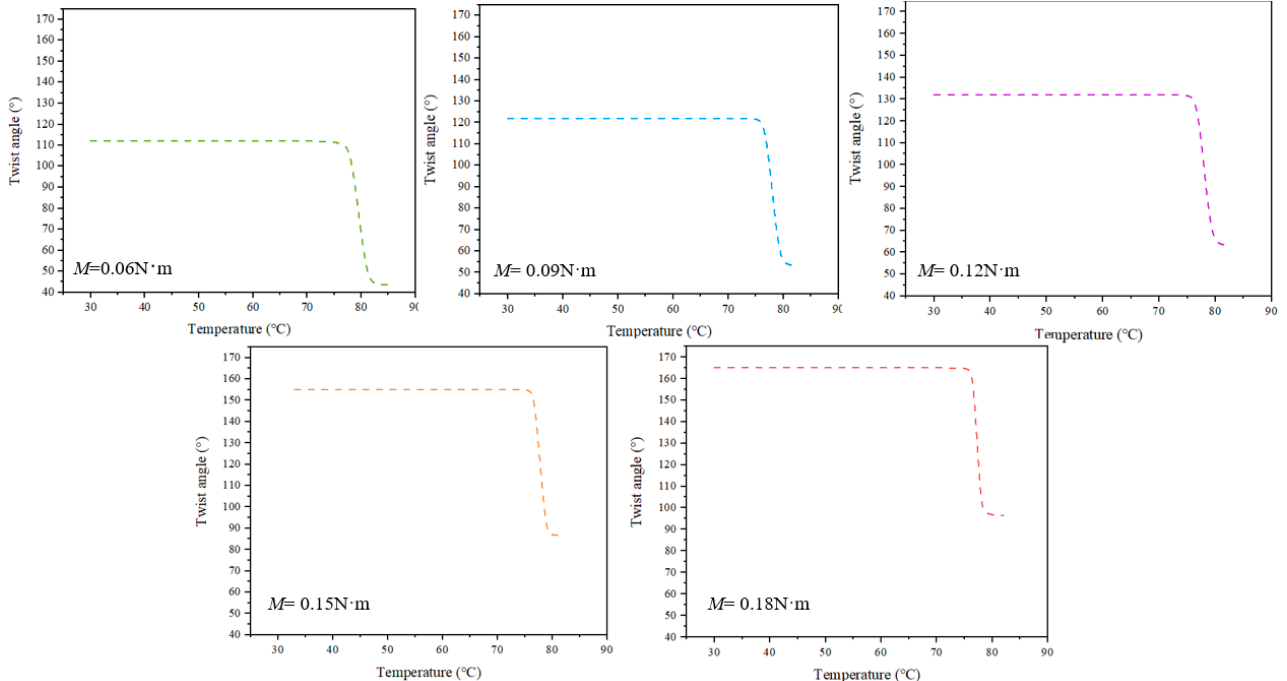
Figure 2. The analytical results of the twist angle–temperature curves of the SMAMS with different applied torques.